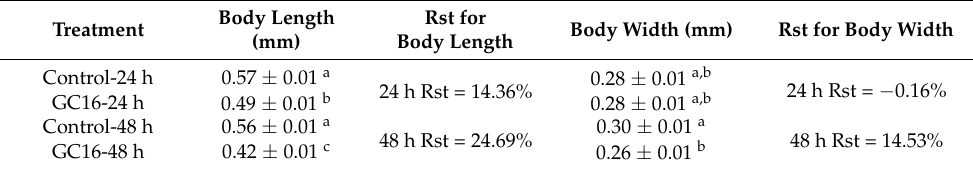
Figure 3. The morphology of female adults for T. pueraricola after GC16 treatment by slide-dip method for 24 h and 48 h. The red arrow indicates that the legs of mite were bent and curled up after treatment with GC16. Table 3. Mean (± SE) body length and width of female adult T. pueraricola under GC16 treatment.